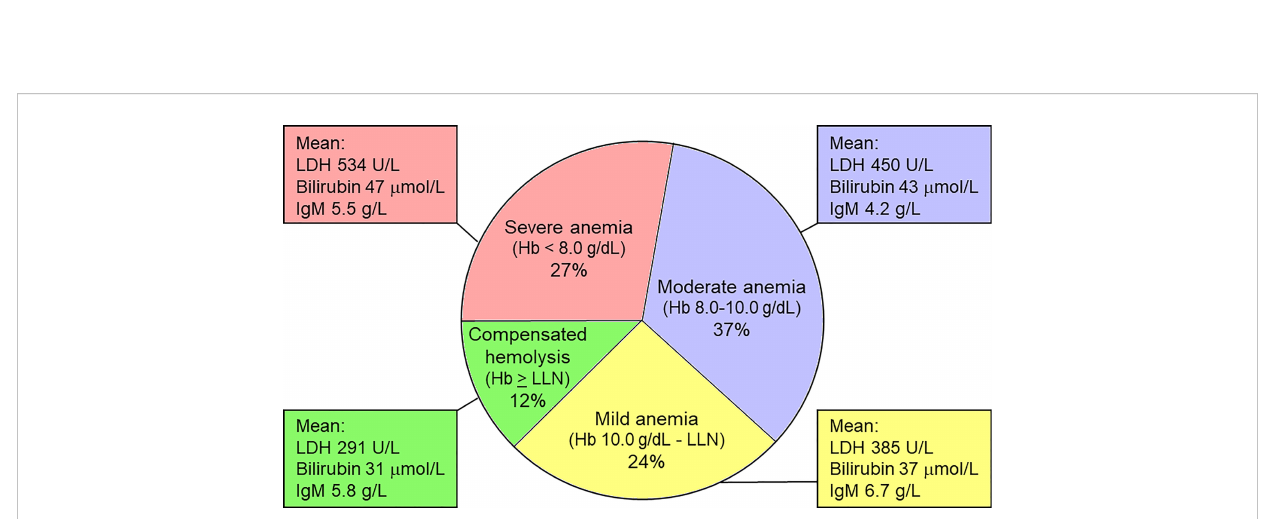
FIGURE 2 Severity of anemia in CAD. Hemoglobin levels correlate negatively with parameters of hemolysis, but do not correlate with IgM levels. LDH, lactate dehydrogense; LLN, lower limit of normal. Based on data from Berentsen et al. (61). Figure fi rst published in Front Immunol 2020 by Berentsen (71), reused under a Creative Commons CC-BY license 4.0 (https://creativecommons.org/licenses/by/4.0/). © S. Berentsen